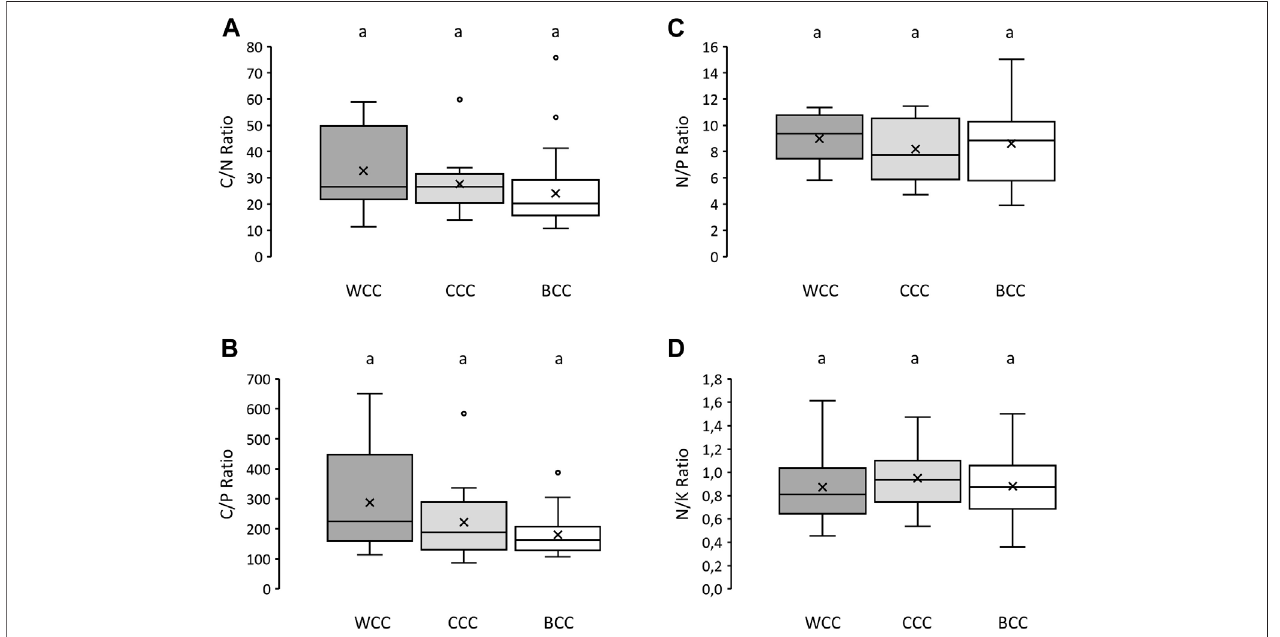
FIGURE 10 | Box and whiskers plots of C/N (A) , C/P (B) , N/P (C) and N/K (D) ratios of the of TSCC for each of the cover crop layouts. Horizontal black line, x-shaped cross, box borders and whiskers stand for the median, the mean, quartiles and outliers. Different letters over the box-plot indicate signi fi cant differences ( p < 0.05). WCC, CCC and BCC stand for olives groves where TSCC occupied the whole area, was absent under tree canopy or only occupied a strip of the inter-row area,